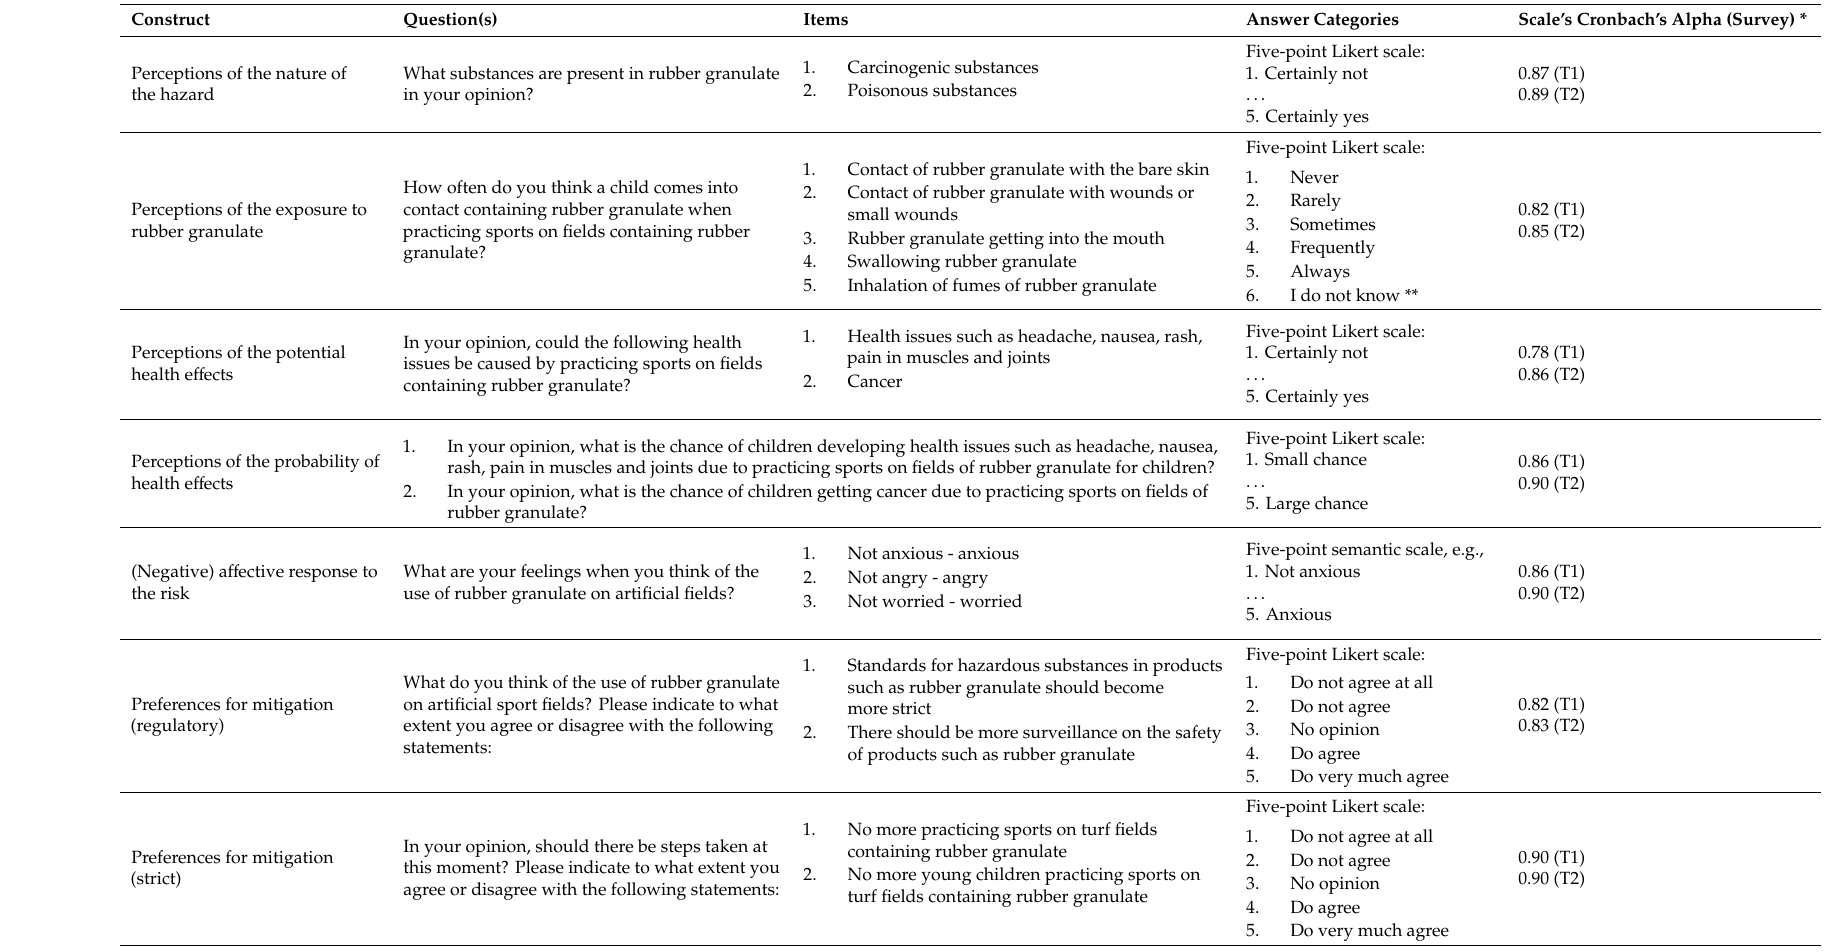
Table 1. Operationalization of dependent variables. The names of the constructs, the corresponding survey questions, items and answer categories, and the Cronbach’s Alphas which resulted from the reliability analyses are presented